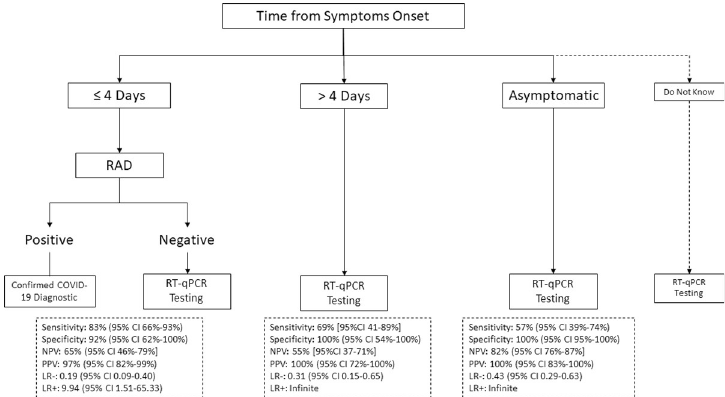
Fig 3. Stepwise algorithm combining rapid antigen detection and RT-qPCR. PPV, positive predictive value; NPV, negative predictive value; LR-, negative likelihood ratio; LR+, positive likelihood ratio.